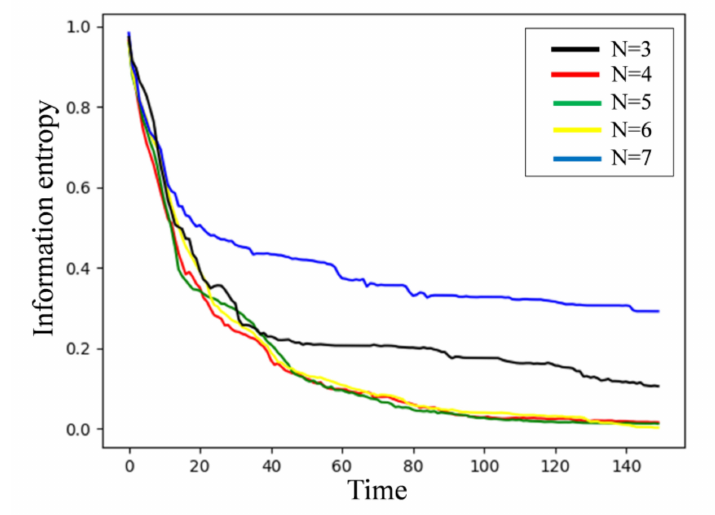
Figure 7. Changes in information entropy with di ff erent numbers of AUVs.